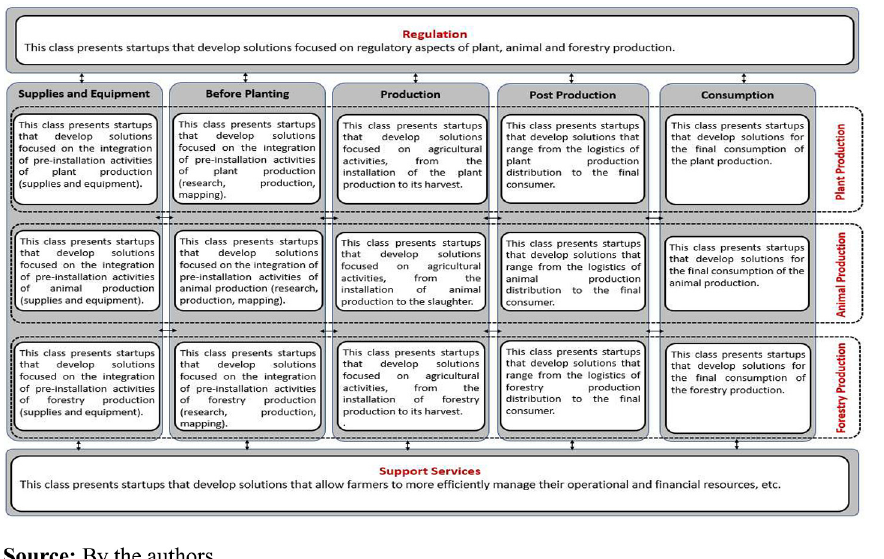
Figure 8. Proposed